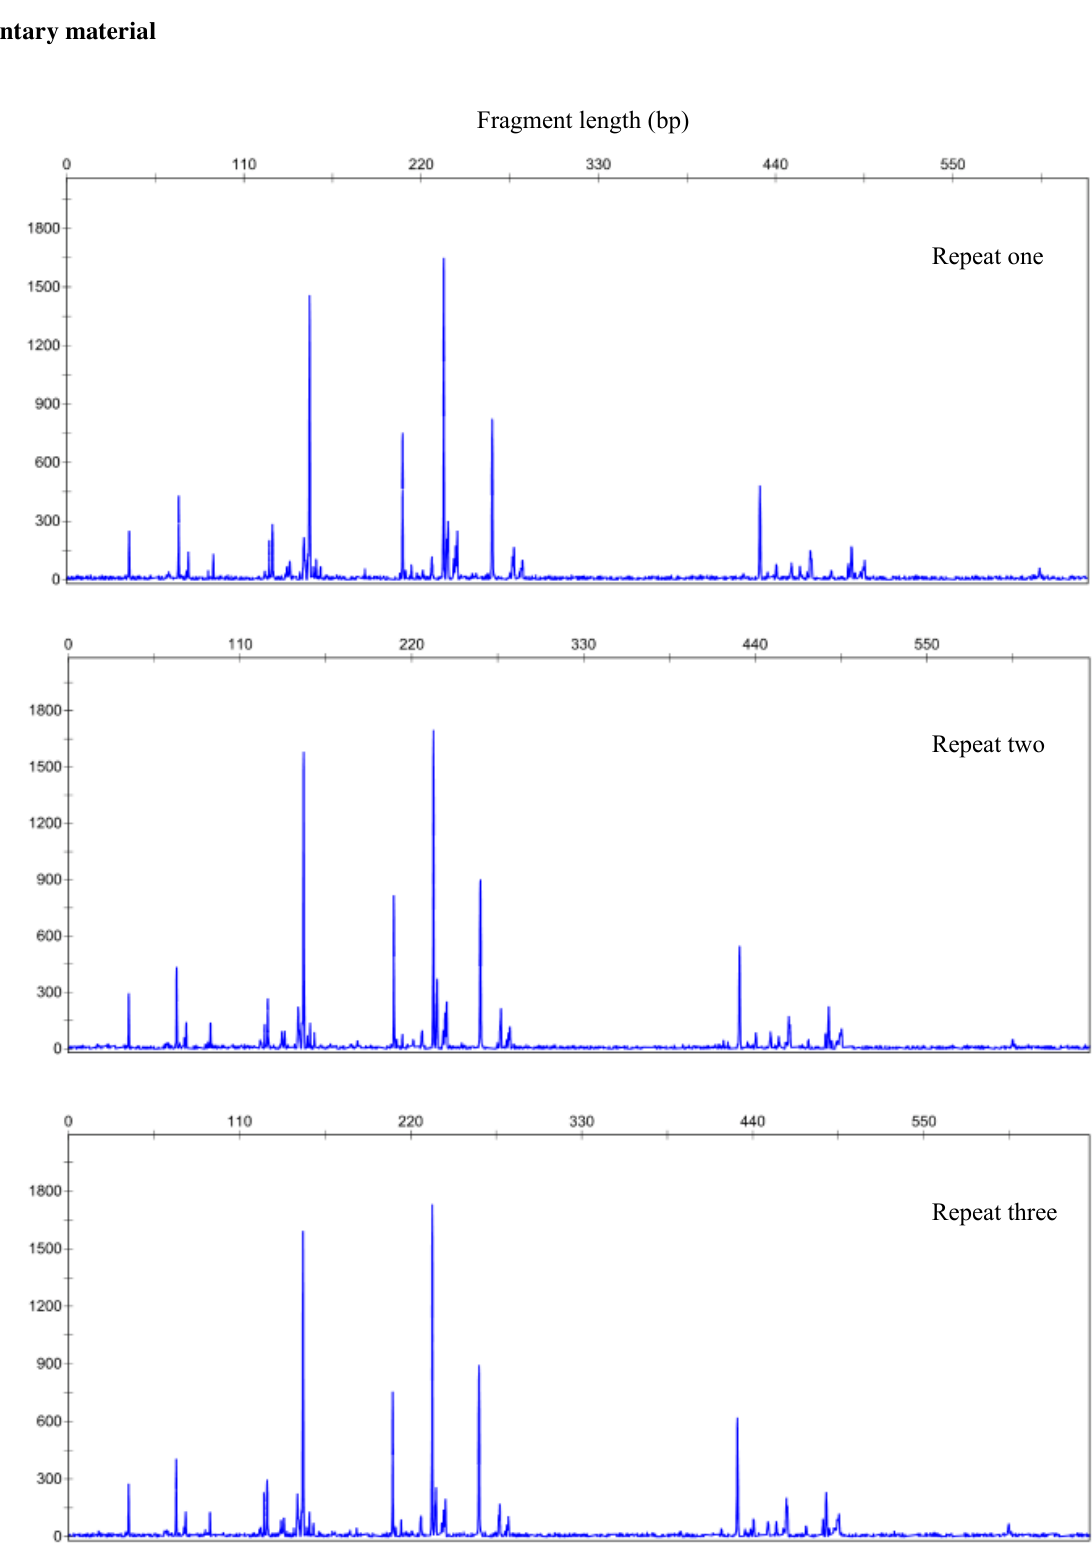
Fig. S1: T-RFLP chromatogram of fungi in rhizosphere soil of tea tree with pH value of